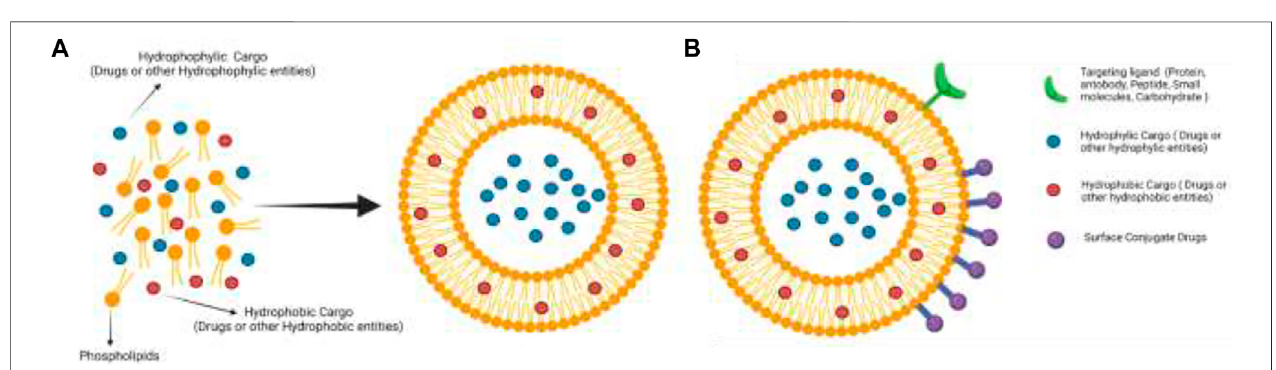
FIGURE 5 | (A) General liposome formation. (B) The general structure of DDS is based on functionalized liposomes.